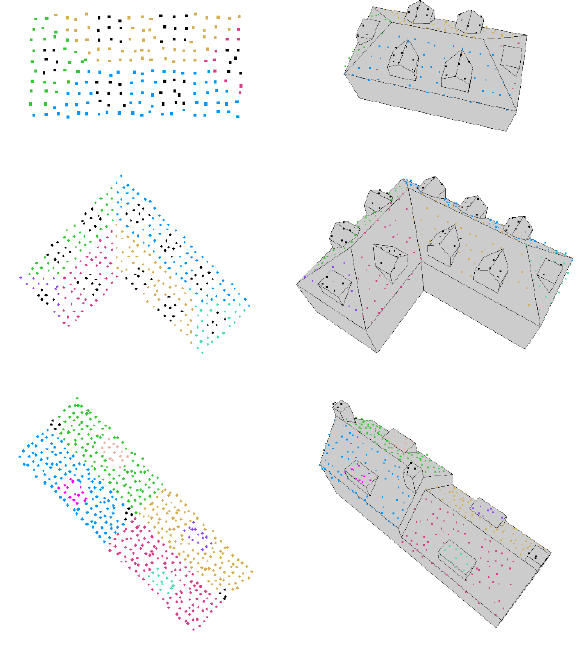
Figure 9. Left: Top view of the segmentation results. Unsegmented points are colorized in black. Right: The resulting building model reconstructed by our proposed approach.